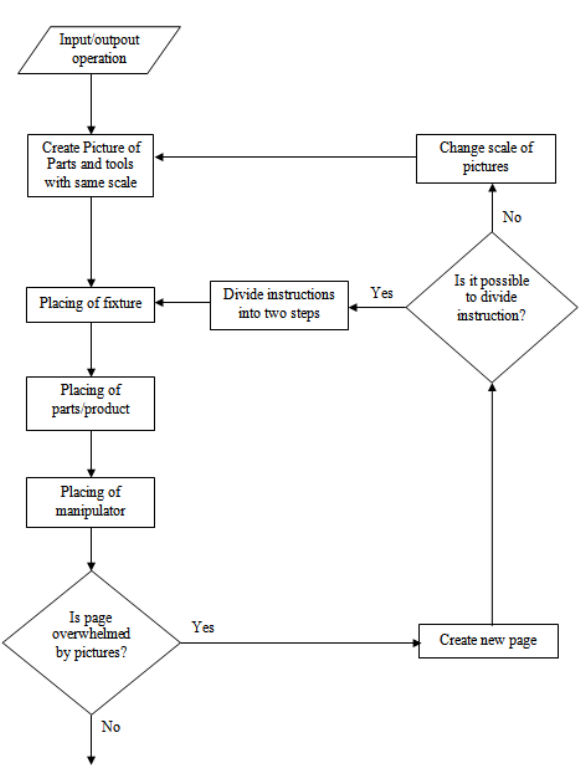
Figure 8: Second part of a